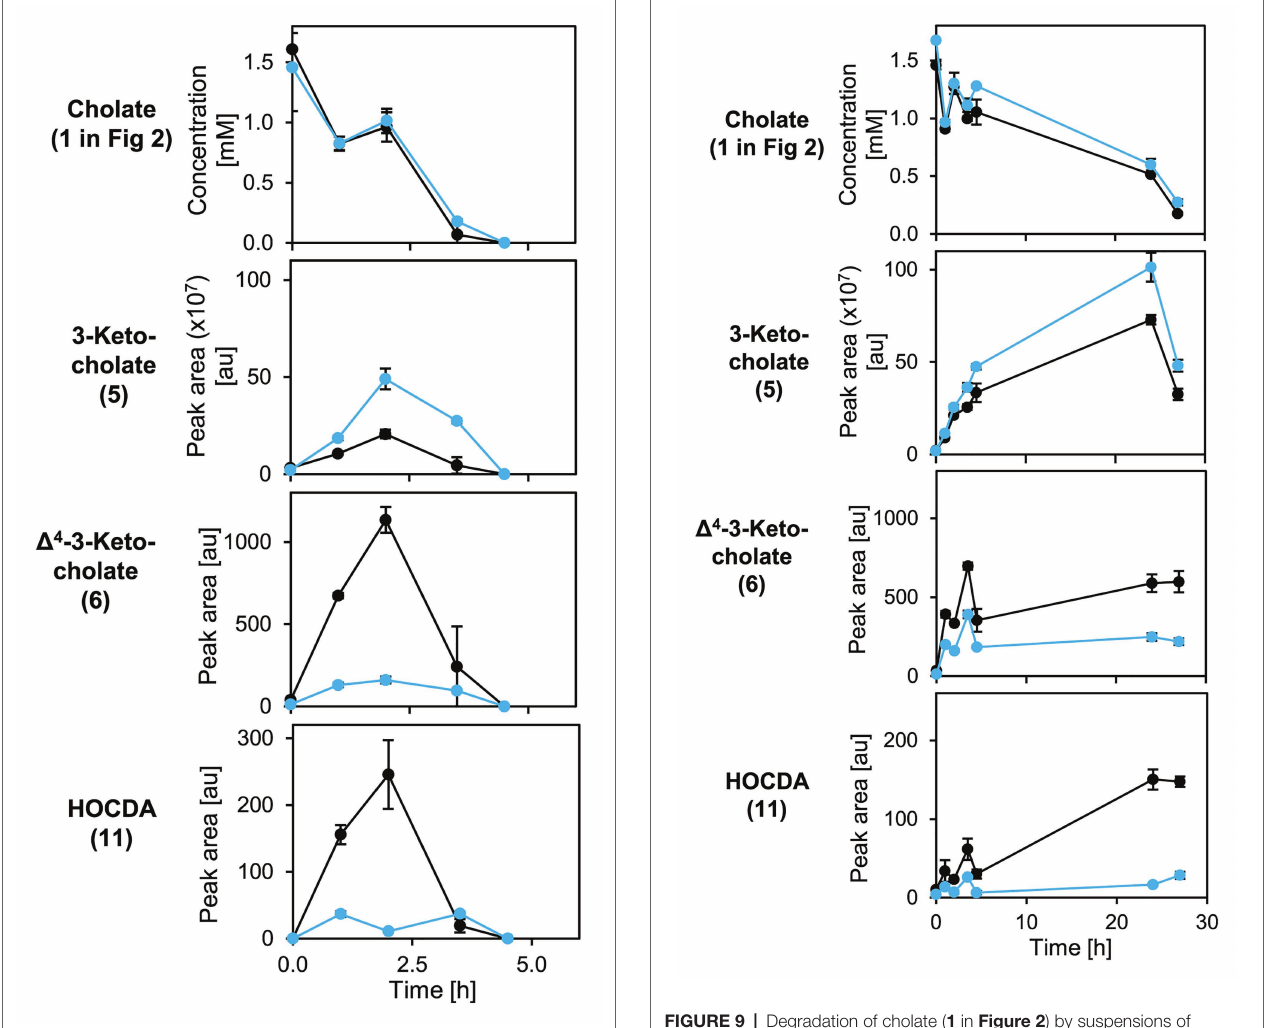
Δ4-kstd1 (blue; OD 600 = 1) in presence of chloramphenicol and transient accumulation of intermediates 3-ketocholate ( 5 ), Δ 4 -3-keto-cholate ( 6 ), and HOCDA ( 11 ) in the cell-free culture supernatant. Chloramphenicol was added after preparation of cell suspensions prior to substrate addition. Error bars indicate SD, which may not be visible if too small ( n = 3).